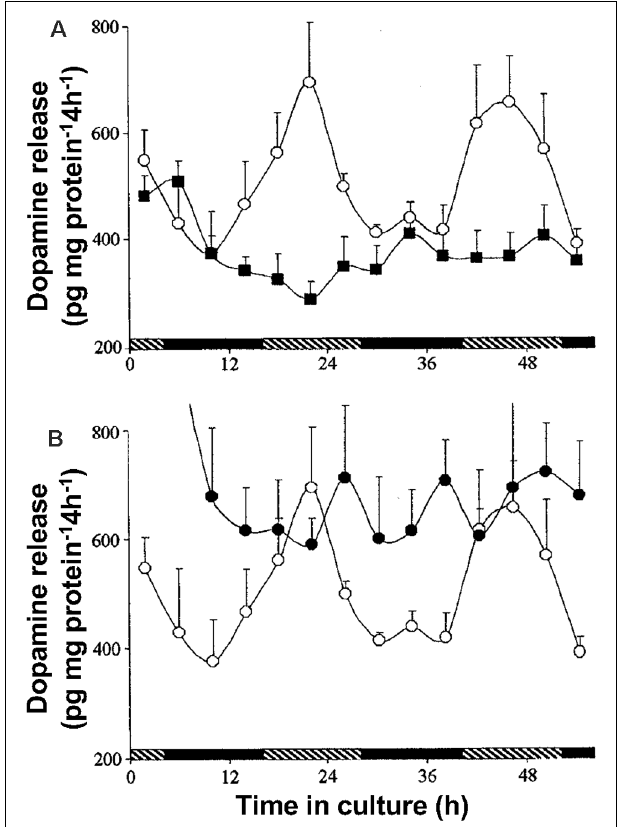
FIGURE 9 | The retinal clock uses melatonin to produce the circadian release of dopamine. (A,B) Isolated intact goldfish neural retinas were maintained for 56 h in a culture medium in constant darkness and temperature. High performance liquid chromatography was used to measure dopamine levels in culture medium sampled every 4 h. A clear circadian rhythm was observed with higher levels of dopamine during the day. (A) Continuous application of melatonin (1 nM; filled squares) to retinas for 56 h, abolished the rhythm of dopamine release by decreasing daytime levels to nighttime values. (B) Continuous application of the selective melatonin antagonist luzindole (1 µ M; filled circles) abolished the rhythm of dopamine release by increasing the nighttime values to daytime levels. Each data point represents mean values ± SEM. Open circles in both (A) and (B) represent positive controls performed at the same time, but with no test drugs added. Hatched and filled bars indicate the subjective day and night, respectively. Modified from Ribelayga et al. (2004). FIGURE 10 | Cone horizontal cells respond to very dim (low scotopic) light